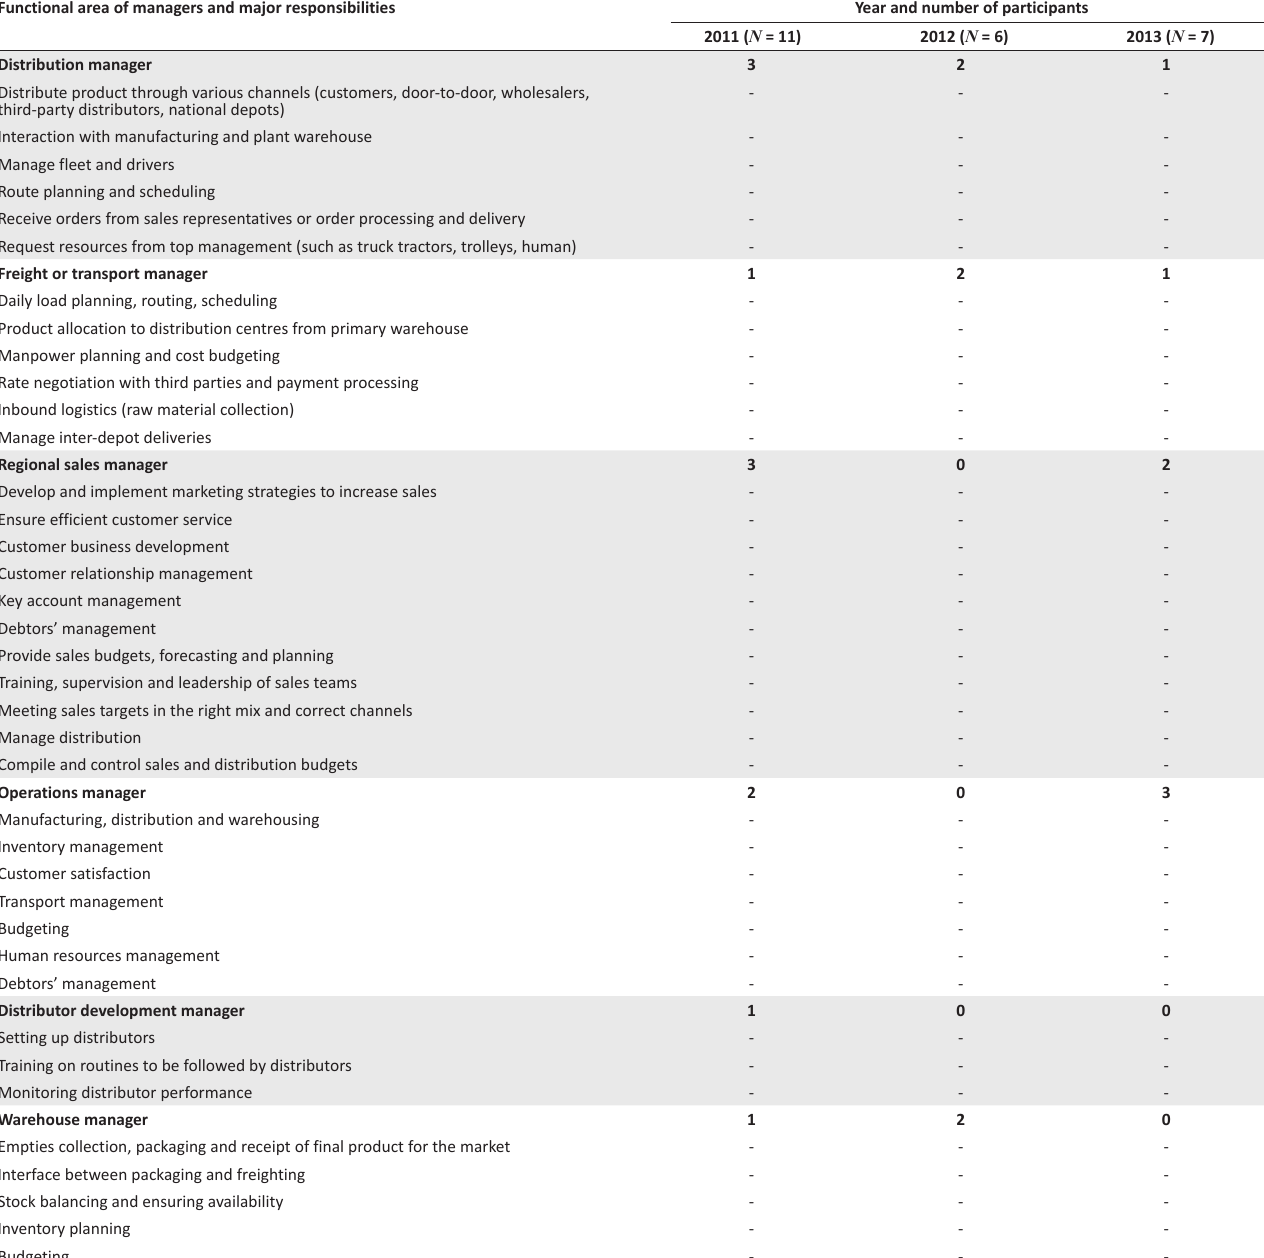
TABLE 1: Participants’ functional areas and major responsibilities, as they reported on questionnaire. Functional area of managers and major